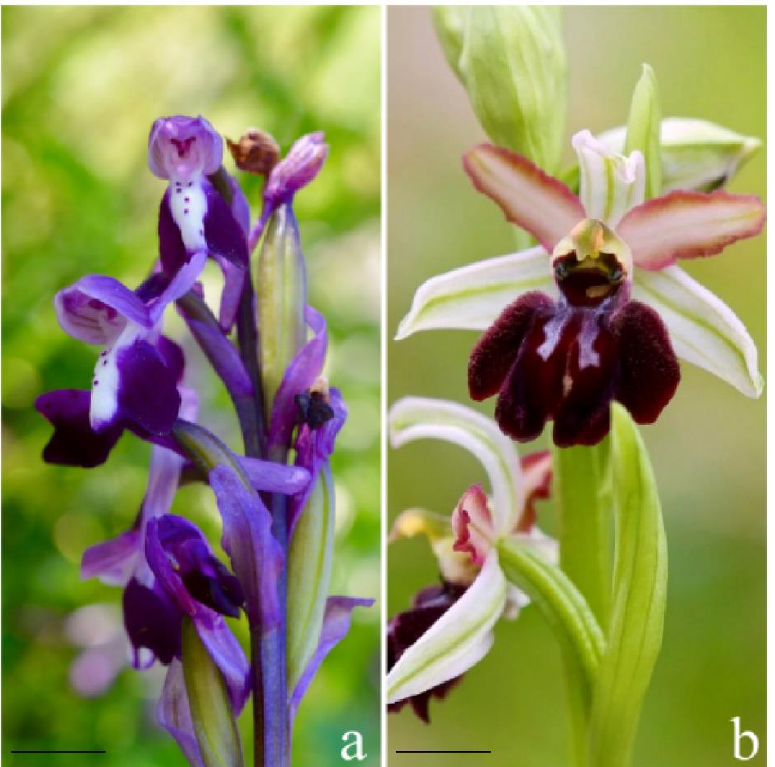
Figure 1. ( a ) Specimen of Anacamptis longicornu growing on Pizzo Neviera (PA); ( b ) Ophrys panormitana . (Photo: Amata Ciro). Bars: 8 mm ( a ); 5 mm ( b ).